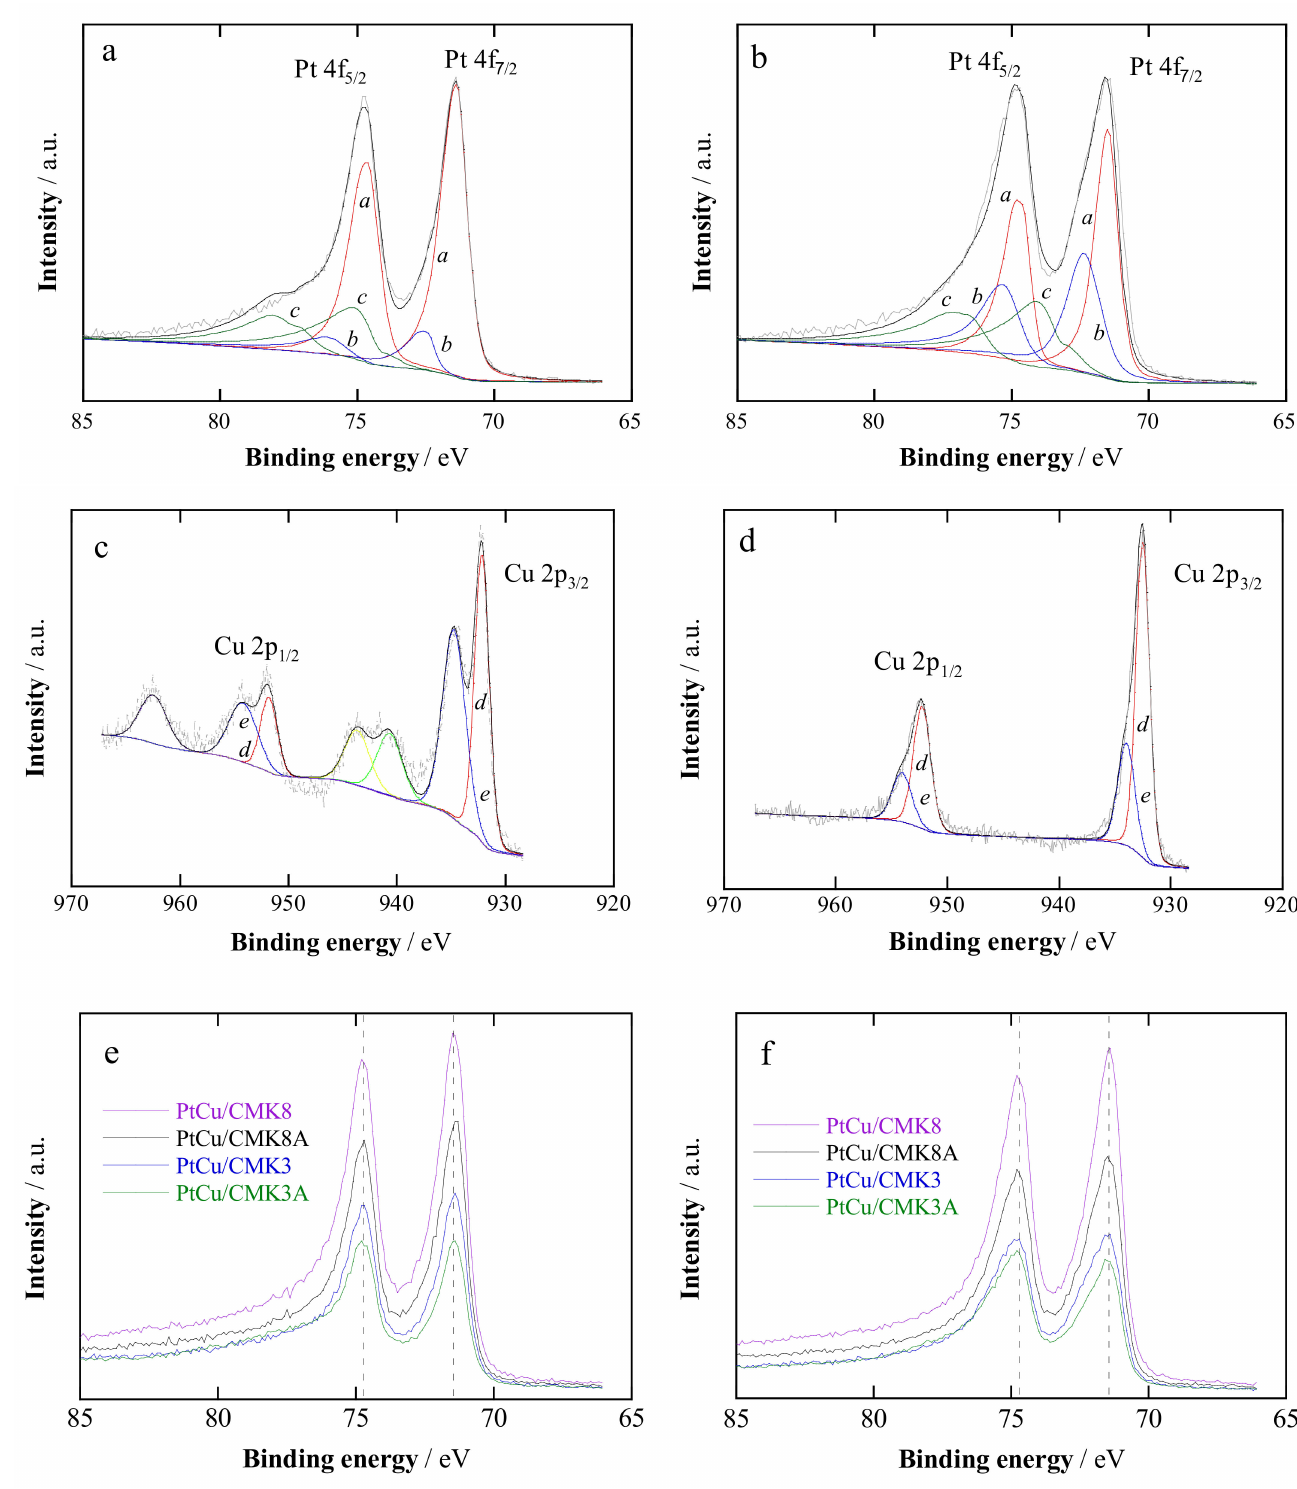
Figure 2. High-resolution XPS spectra of Pt(Cu)/CMK3 in the ( a ) Pt 4f BE region before and ( b ) after sputtering; and in the ( c ) Cu 2p BE region before and ( d ) after sputtering. The Pt 4f peaks in all the specimens are compared ( e ) before and ( f ) after sputtering. Curves a , b and c in ( a , b ) correspond to the doublets of Pt(0), Pt(II), and Pt(IV) species, respectively, whereas d and e in ( c , d ) account for the doublets of Cu(0) and Cu(II),